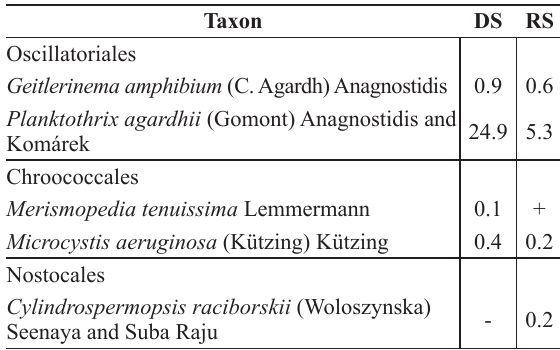
Average values of biomass of cyanobacteria (mm 3 .L -1 ) in the Apipucos reservoir during rainy and dry periods; + = occurrence of biomass less than 0.1 mm 3 .L -1 ; DS = dry season; RC = rainy